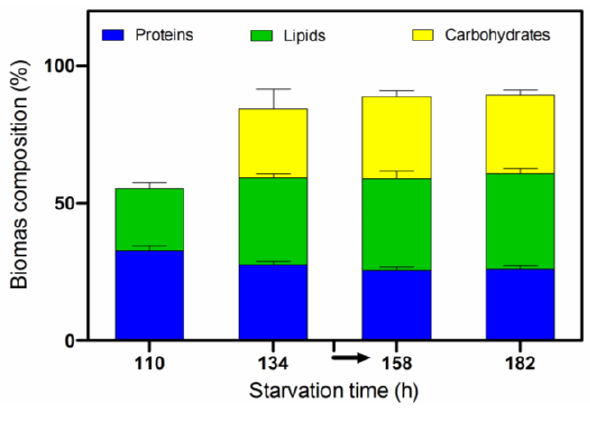
Figure 7. Changes in biomass composition in Chlorella vulgaris CCALA 896 versus time, during the N and P starvation phase. The arrow indicates the beginning of the pH-stressed conditions. A F PBR with a working volume of 550 mL was used. The data represent the G mean ±